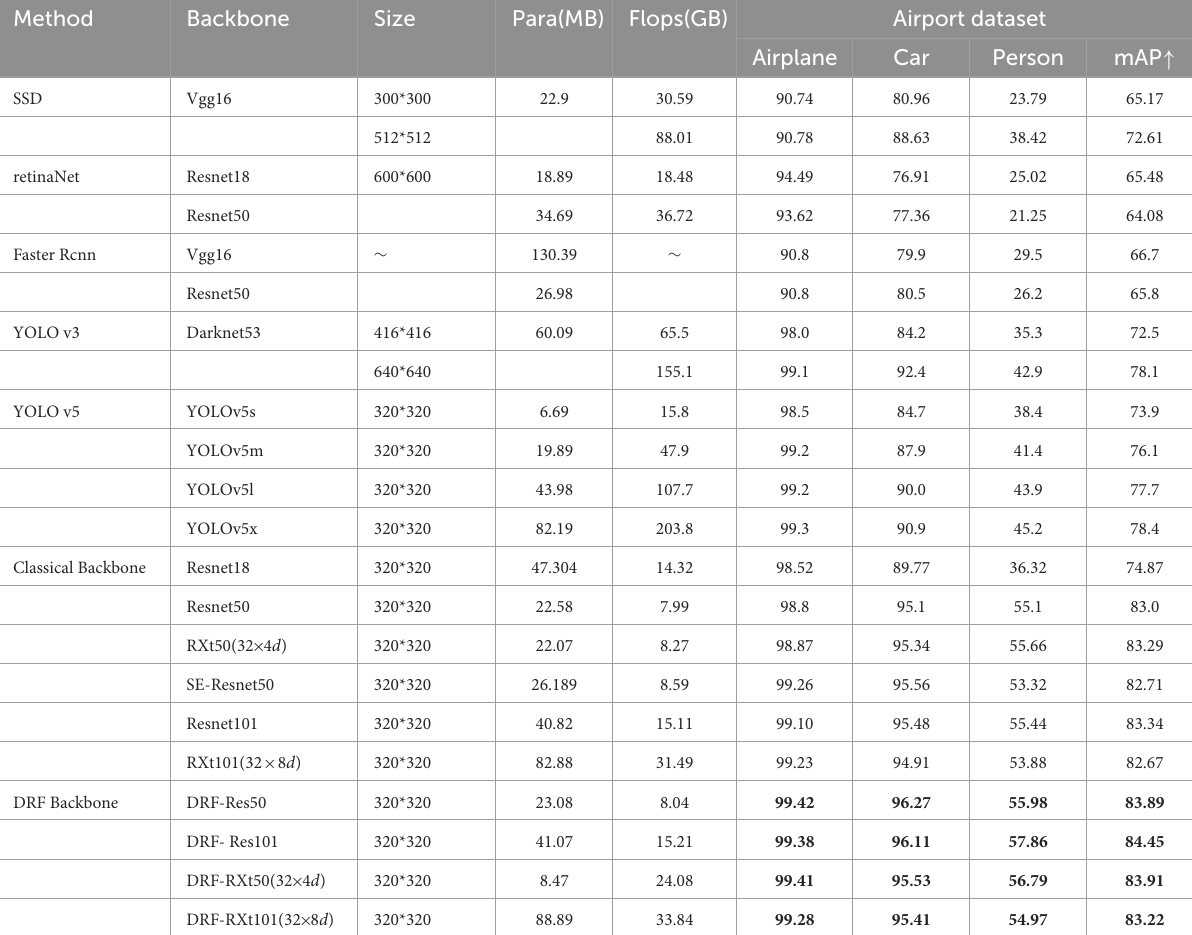
TABLE 6 Performance comparisons with various SOTA object detection frameworks on the airport scene